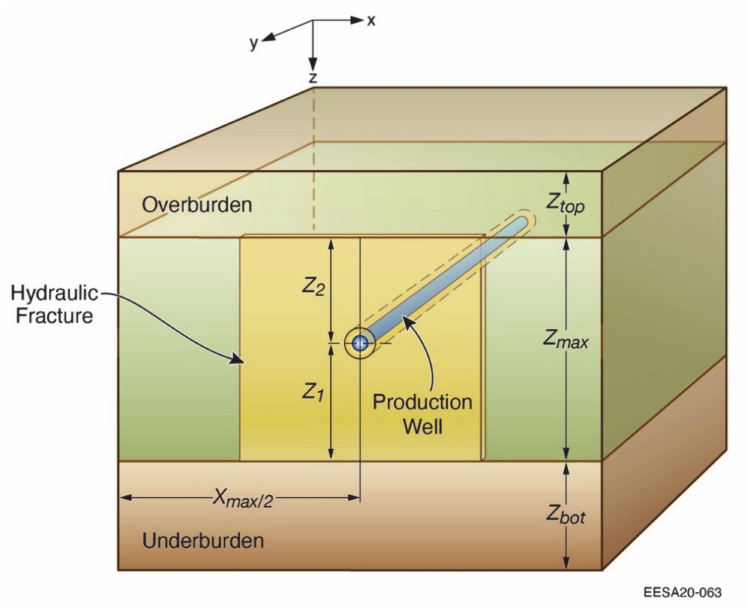
Figure 7. Simulation stencil representing a single fracture in a single stage along the production well. Note the plane of symmetry at the fracture face (this is a 1 -space problem). No-flow boundaries at 2 the left and right edges imply that the well is part of a series of parallel wells with spacing X max .